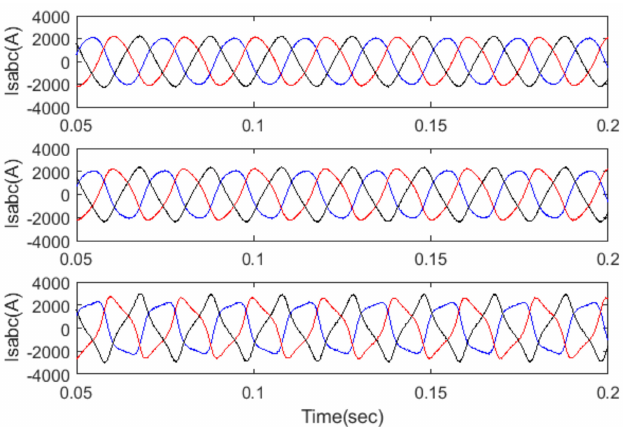
Figure 9. Rotor current under unbalanced grid voltage.